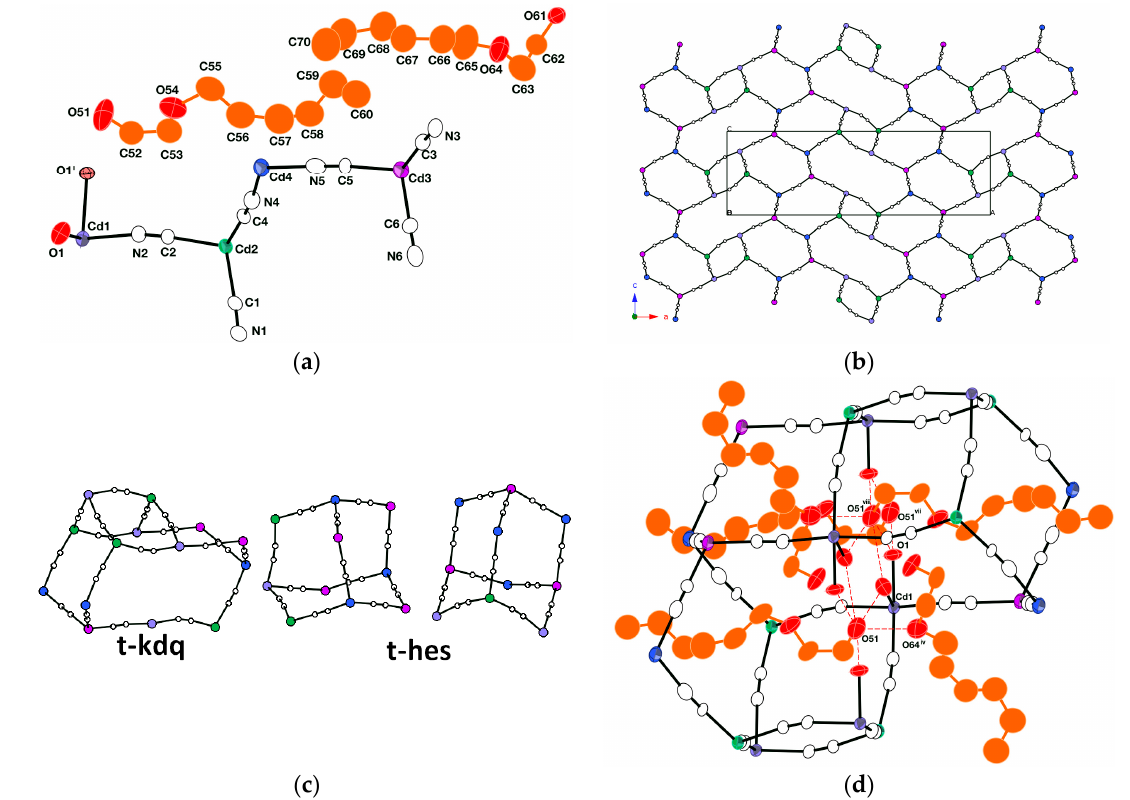
Figure 3. Crystal structure of III . H atoms and disorder parts are omitted for clarity: ( a ) Asymmetric unit of III . Displacement ellipsoids are drawn at the 30% probability level. Because arrangements of cyanides (Cd–NC–Cd or Cd–CN–Cd) are disordered, the atoms of cyanide are labeled less clearly; ( b ) The Cd(CN) 2 network structure of III along the b axis; ( c ) [6 4 ] t-hes and [4 2 .6 2 .8 2 ] t-kdq tiles; ( d ) Hydrogen bonds between Hexcel and water molecules in cavities of cadmium cyanide network. Displacement ellipsoids are drawn at the 30% probability level. (symmetry codes: iv = x + 1/2, y , − z + 3/2; vii = x , y − 1, z ; viii = − x + 1, − y + 1, − z + Table 4. Selected Parameters for III .